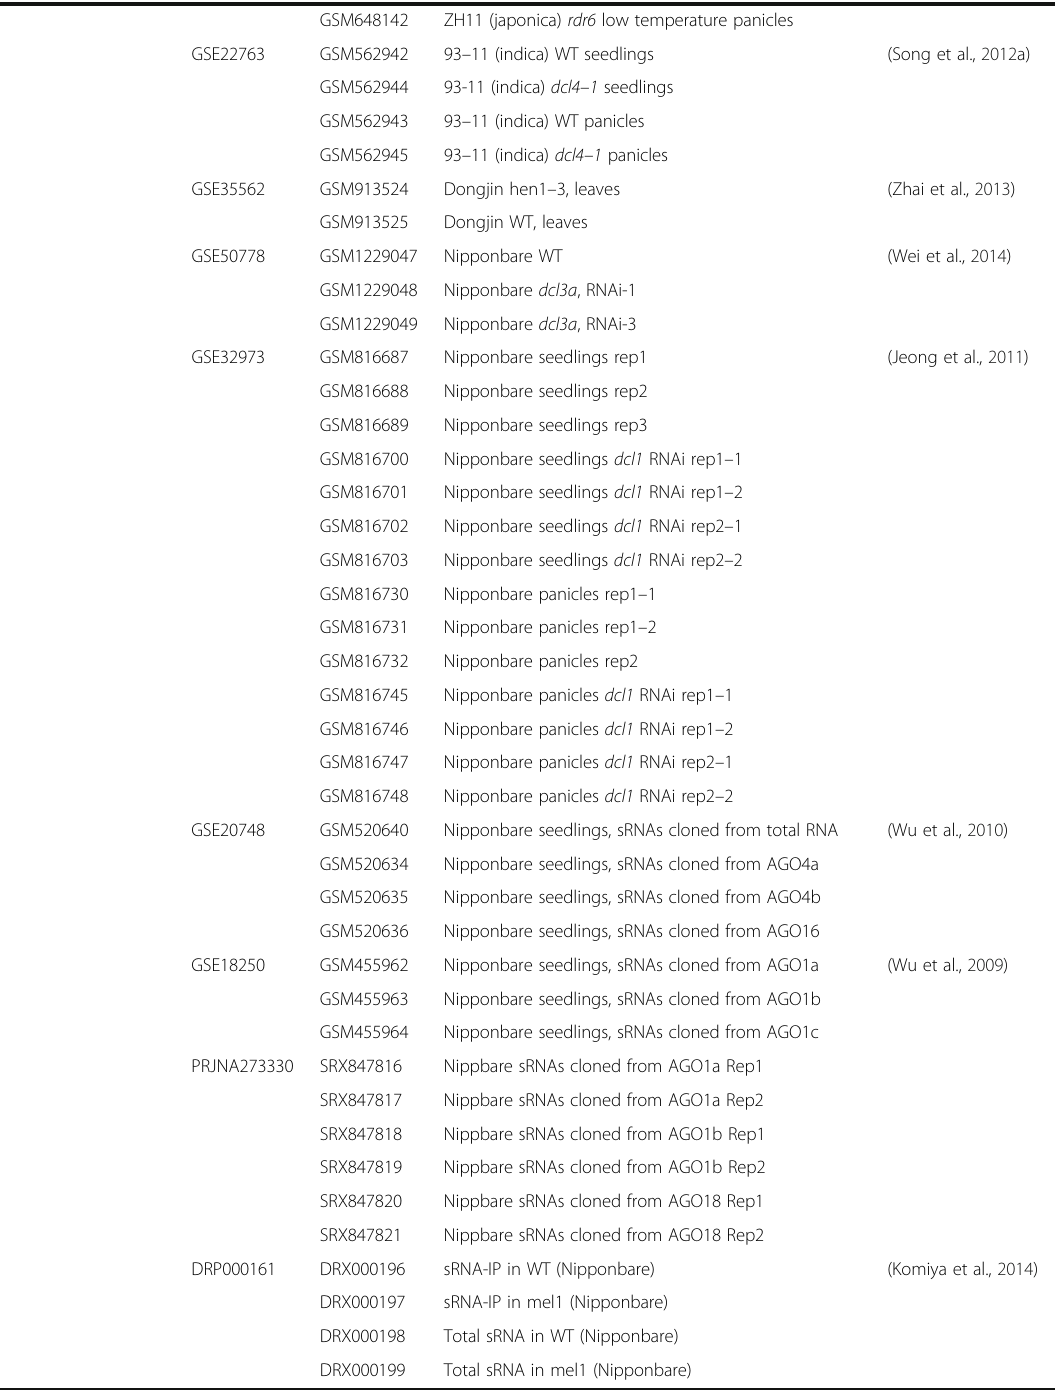
Table 3 List of sequencing data for plant small RNA research